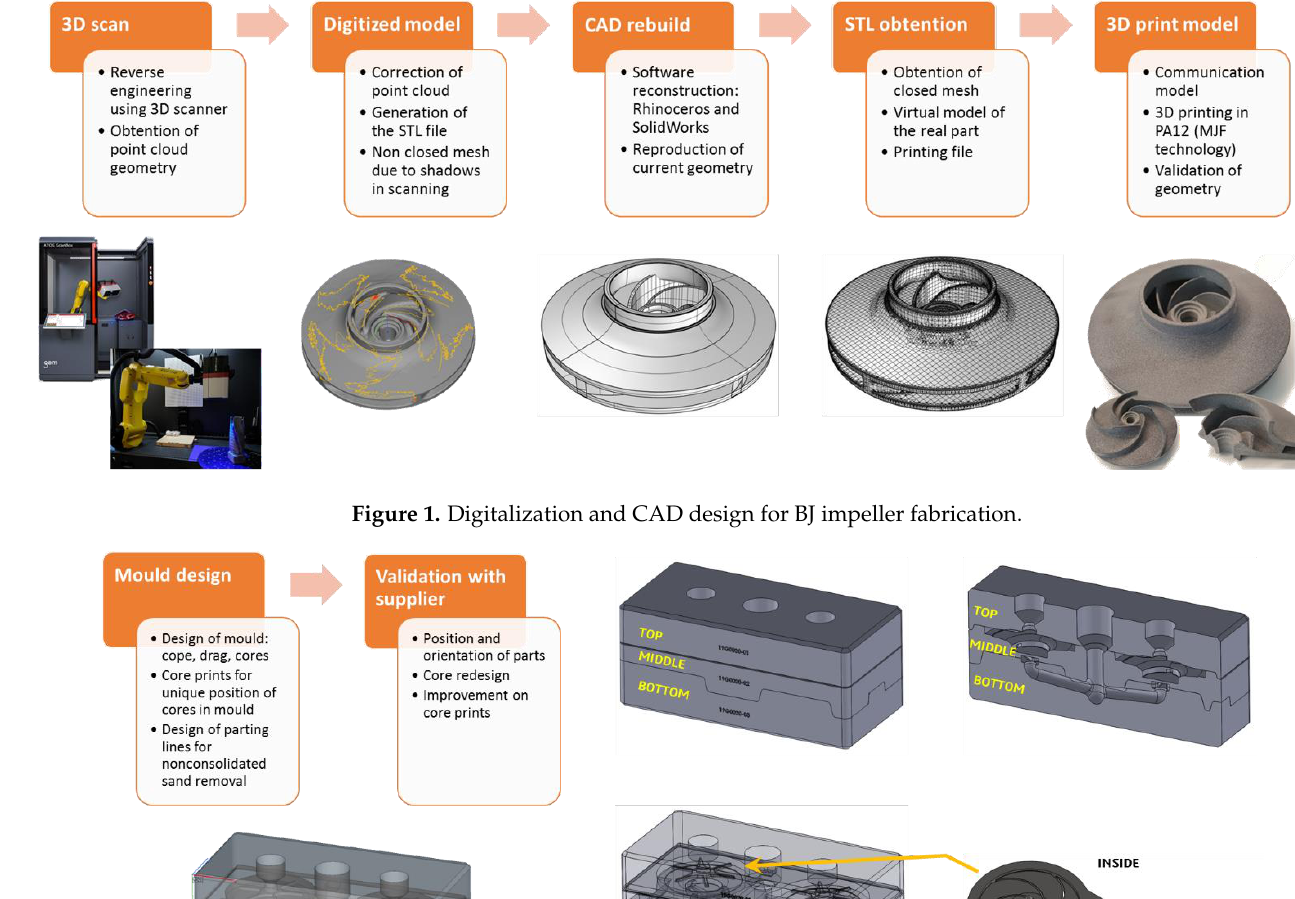
Figure 1. Digitalization and CAD design for BJ impeller fabrication.